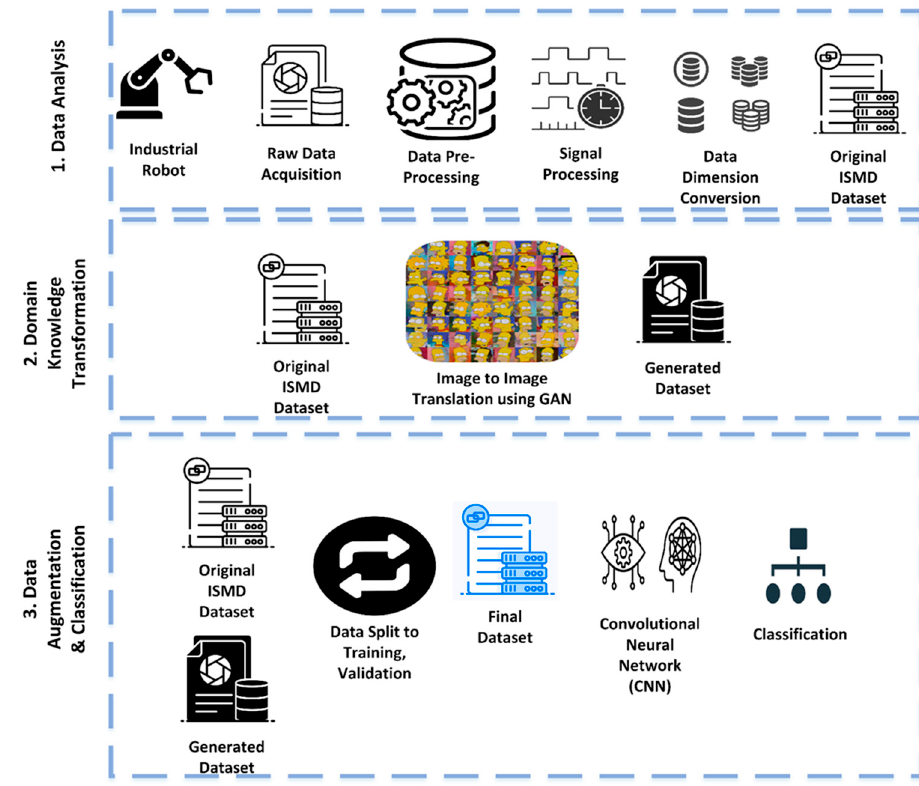
Figure 4. Basic architecture of the proposed fault detection and diagnosis